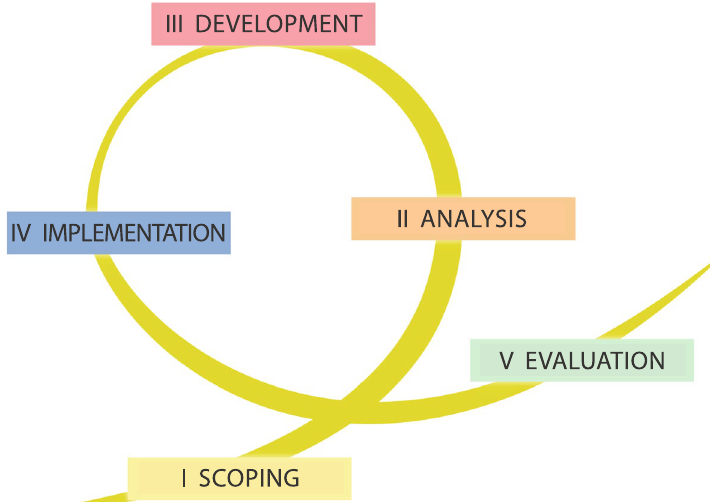
Fig. 5 The five phases of heritage-based urban development (Source: Ripp